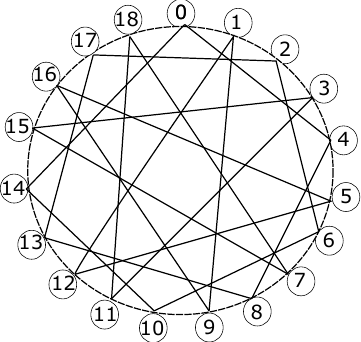
Figure 7. Node distribution of a Robertson